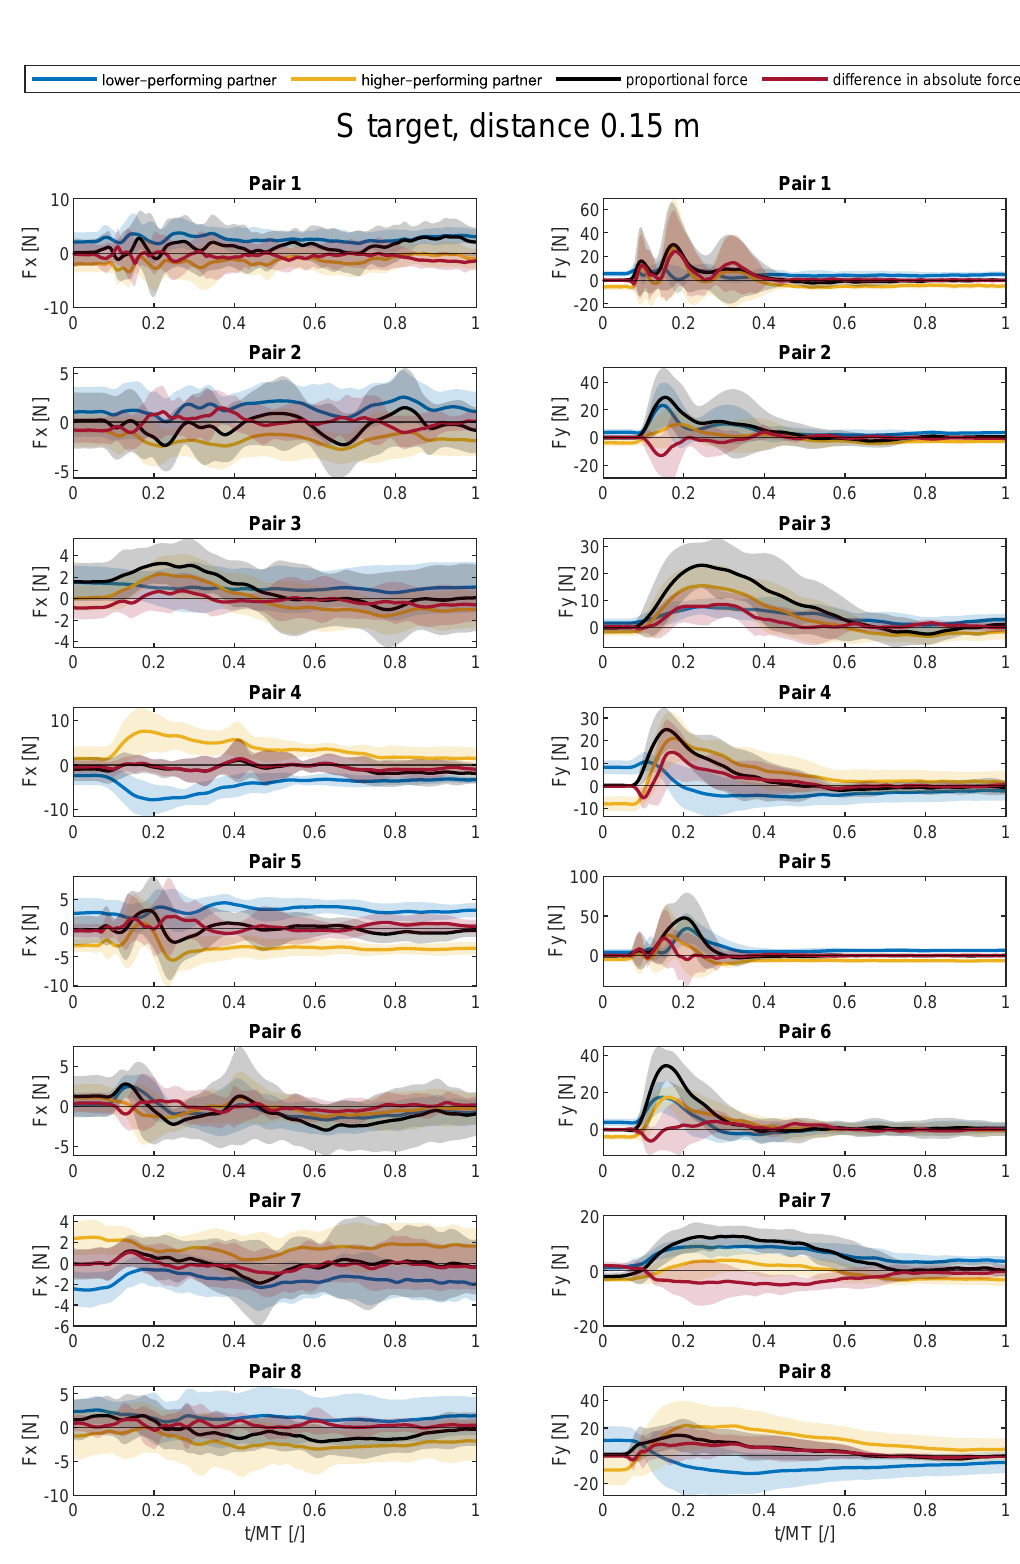
Figure A2. Average force trajectories with standard deviation (shaded area) in x- and y-direction in collaborative task for the small target at the distance of 0.15